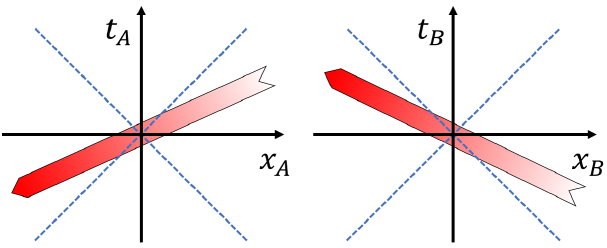
FIG. 2. Minkowski diagrams of the argument outlined in Sec. III A. Reference frame of Alice (left panel): the perturbation moves superluminally from the left to the right, and its intensity decreases with time as a result of dissipation. Reference frame of Bob (right panel): the perturbation moves from the right to the left, and its intensity grows with time. The two points of view are connected by a Lorentz boost. The shades of red are a color map of the intensity of the perturbation (red large, white small); the arrows have the orientation induced by φ (see the main text); the blue dashed lines are the light